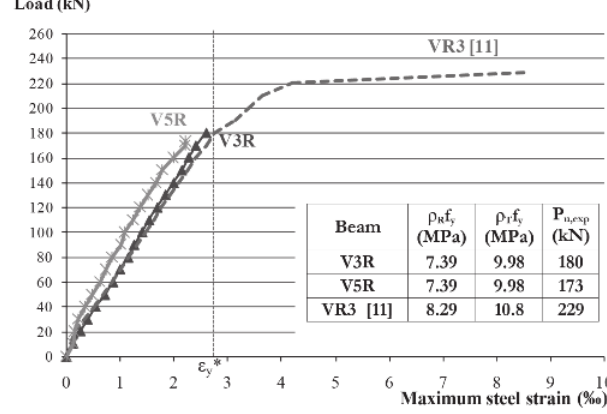
Load - maximum longitudinal steel strain curves for beams VR3 [11], V3R and V5R